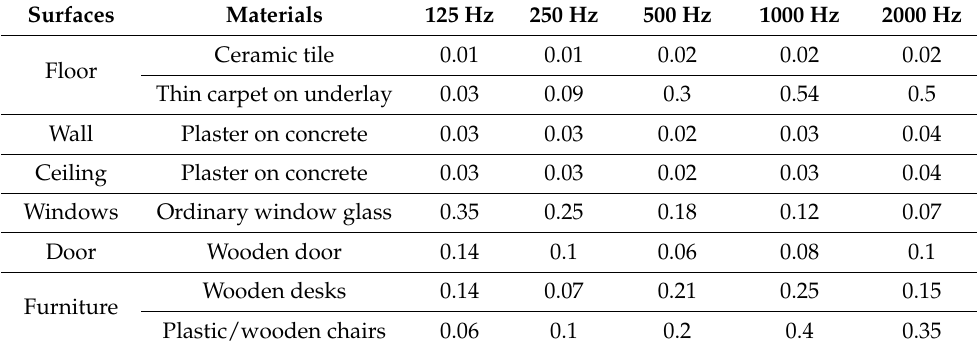
Table 3. Modified absorption coefficients of materials in the room over 1/1 octave